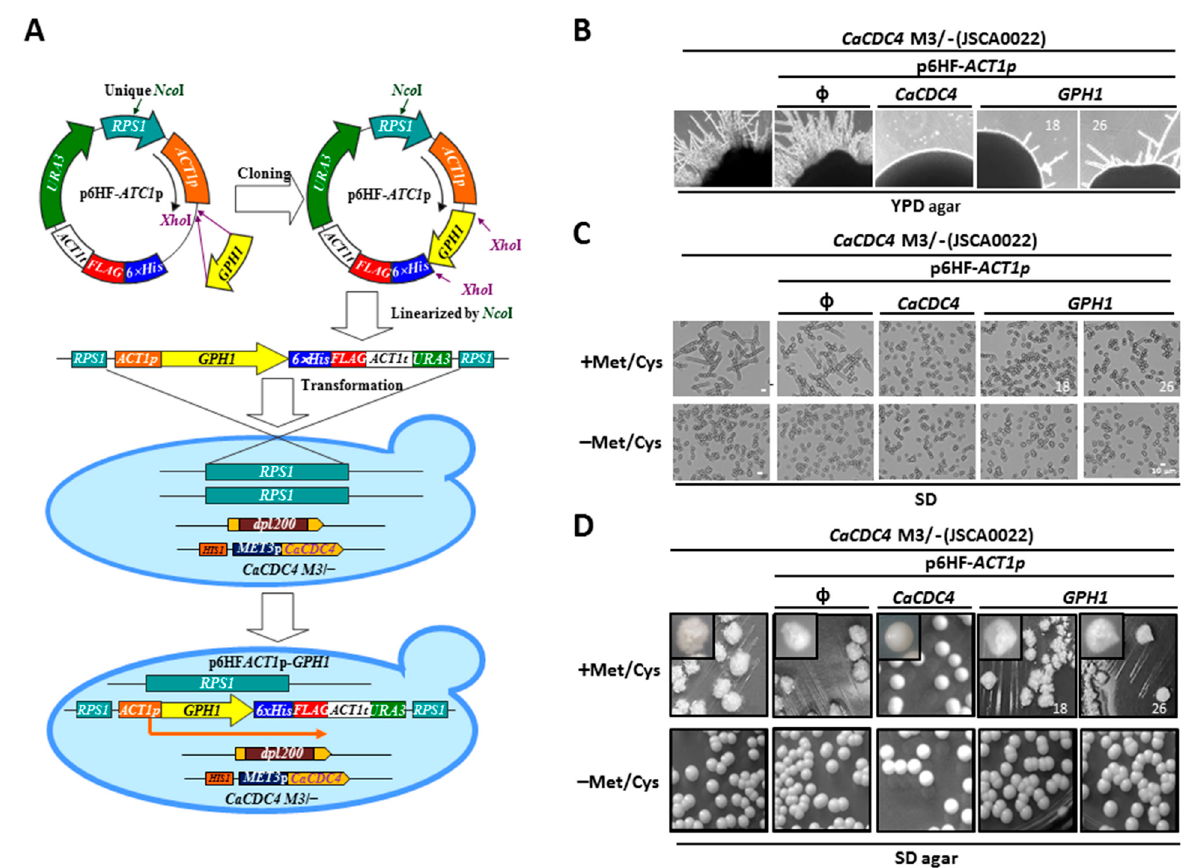
Figure 1. The constitutive expression of GPH1 suppresses the filamentous mode of growth when the expression of CaCDC4 is repressed in C. albicans . ( A ) The diagram illustrates the strains used. The cells were ( B ) plated on YPD plate or were grown in the SD media ( C ) or plate ( D ) with or without 2.5 mM Met/Cys. The “ ϕ ” represents empty plasmid p6HF- ACT1 p. Bars represent 10 μ m. “18” and “26” represent different isolates of strains with p6HF- ACT1 p- GPH1 .